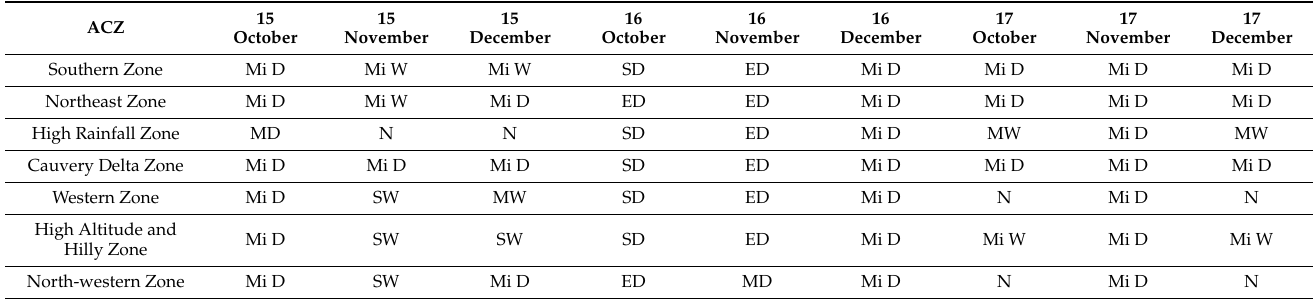
Table 7. Agroclimatic zone-wise SPI for different months during